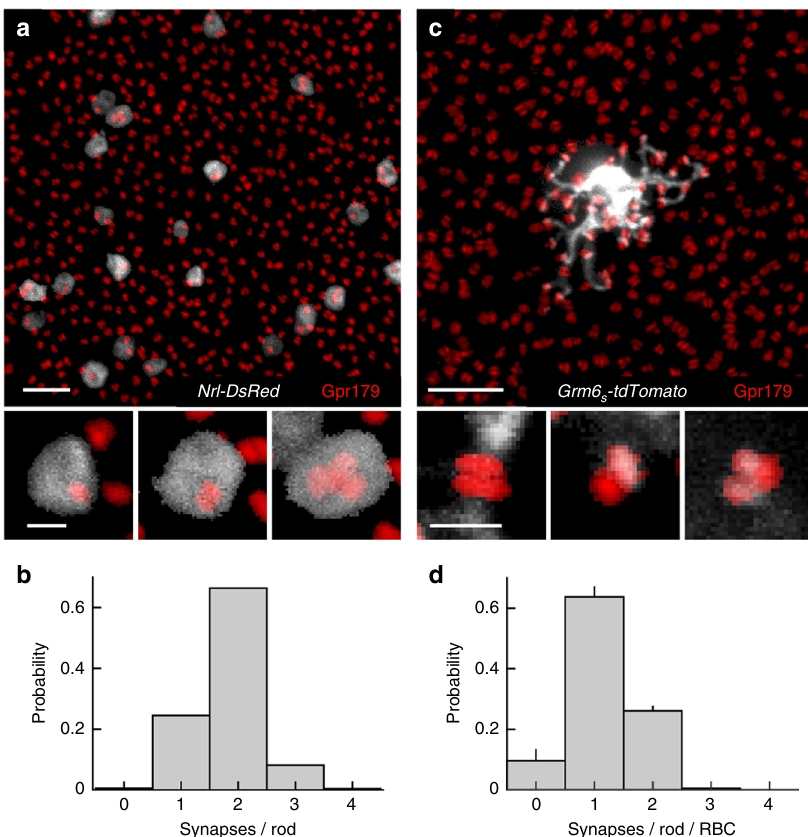
Fig. 1 Rod-RBC synapses exist in different con fi gurations. a Maximum intensity projection of a confocal image stack of the outer plexiform layer of a retina, in which rods were electroporated with Nrl-DsRed (gray) and in which RBC postsynaptic sites were stained for Gpr179 (red). Scale bar represents 5 μ m. The top panel shows an overview, whereas the bottom panels present higher magni fi cation views of individual rod spherules. b Histogram of the number of Gpr179 clusters per rod observed in our data ( n = 555 rods, n = 12 mice). Scale bar represents 0.5 μ m. c Analogous to a , but showing AAV-mediated ( Grm6 S -tdTomato ) labeling of an individual RBC in gray. For visual clarity, the RBC and rod synapses were digitally isolated in Amira. d Population data (mean ± SEM) showing the distribution of postsynaptic densities assembled by each RBC per rod spherule ( n = 29 RBCs, n = 8